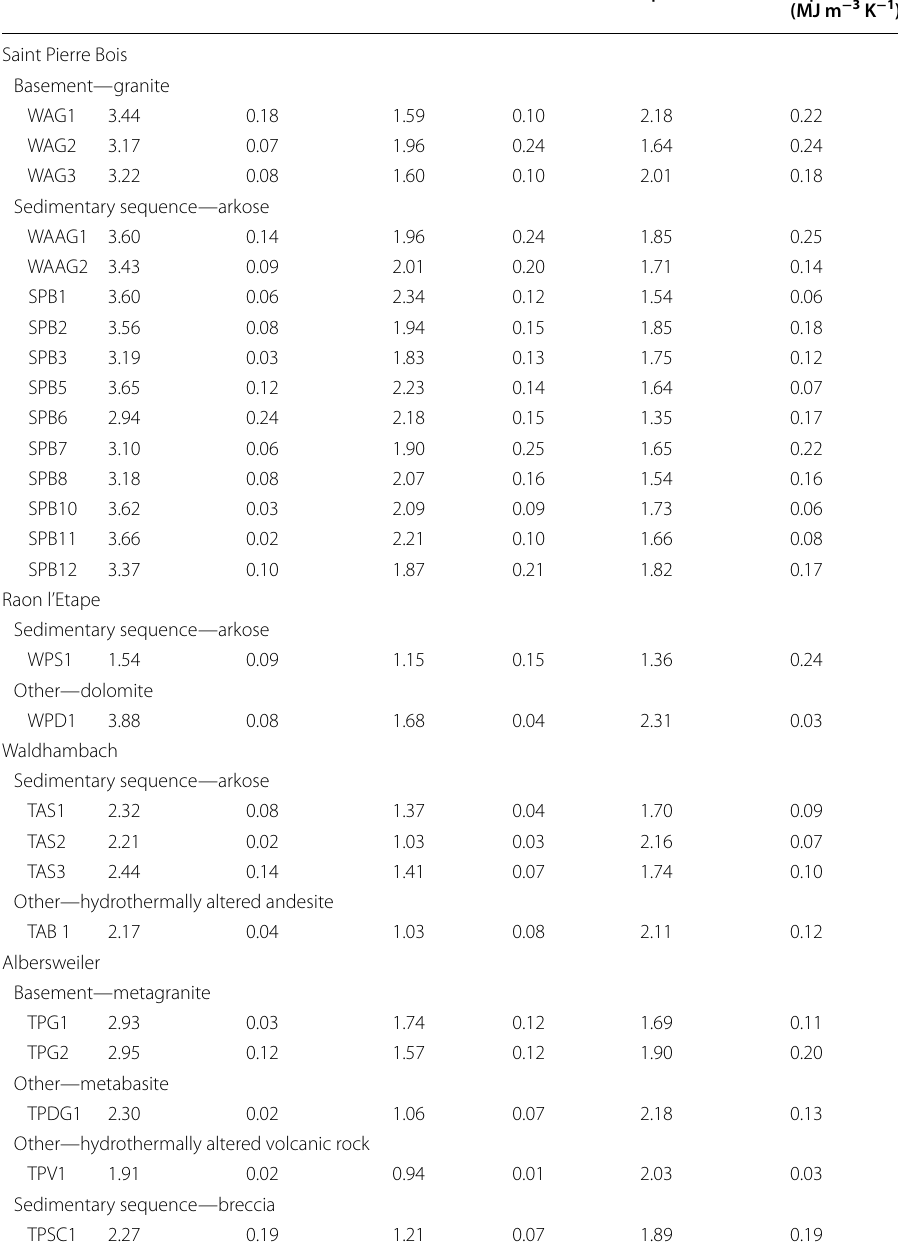
Table 4 Thermal properties of the rocks